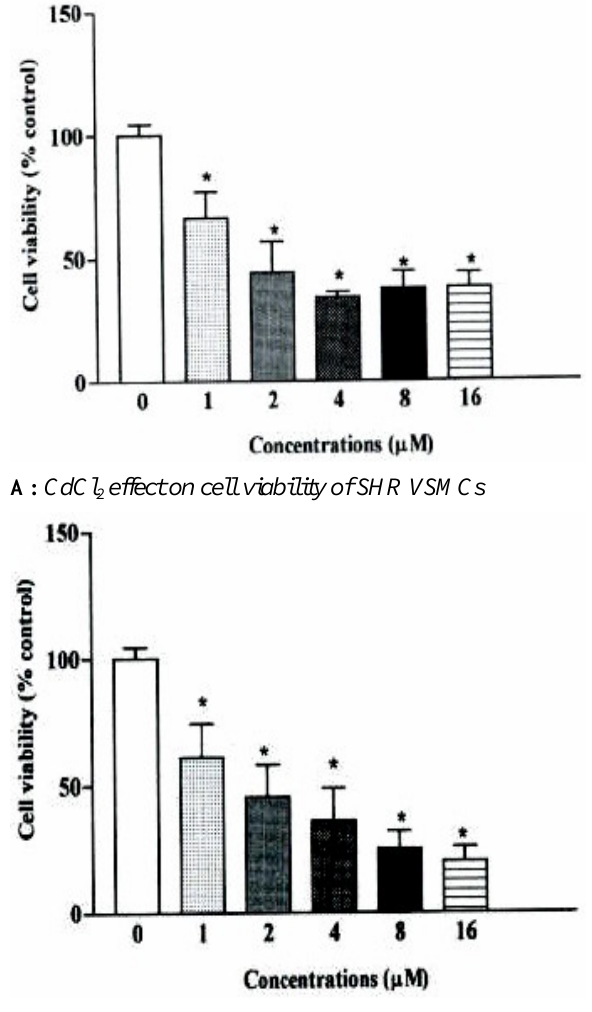
Figure 2: A concentration dependent effect of CdCl expression of ERK 1 & 2 in VSMCs of (A) SHR and (B) WKY rats. VSMCs were stimulated with 1-16 µM of CdCl . Cell were harvested in lysis buffer as described in Figure 1: Effect of CdCl on Cell viability of SHR and 2 2 Material and Methods, and equal protein concentrations (20 WKY vascular smooth muscle cells. Cell viability was µg) were analyzed on a 10% polyacrylamide gel and assessed following incubation of cells with CdCl for 24 2 transferred to a nitrocellulose membrane. ERK 1 & 2 were hr using the trypan blue exclusion method. The mean determined by measuring specific phosphorylated ERK 1 & levels of cell viability for treating cells with 1-16 µM of 2 (pp44 ERK-1 and pp42 ERK-2) by western blot. CdCl on SHR VSMCs (A) were 66.6±10.5, 44.0±12.8, 2 Densitometric analysis of western blots was done to quantify the magnitude of change in phosphorylation of MAPKs induced by CdCl . Bar graph represents intensities of ERK 1 respectively. The data are the mean± SEM of 3 different 2 & 2 bands. The data are the mean± SEM of 3 to 4 different experiments. *Significantly different from time-matched experiments. *p<0.05 compared to time-matched control, p<0.05.